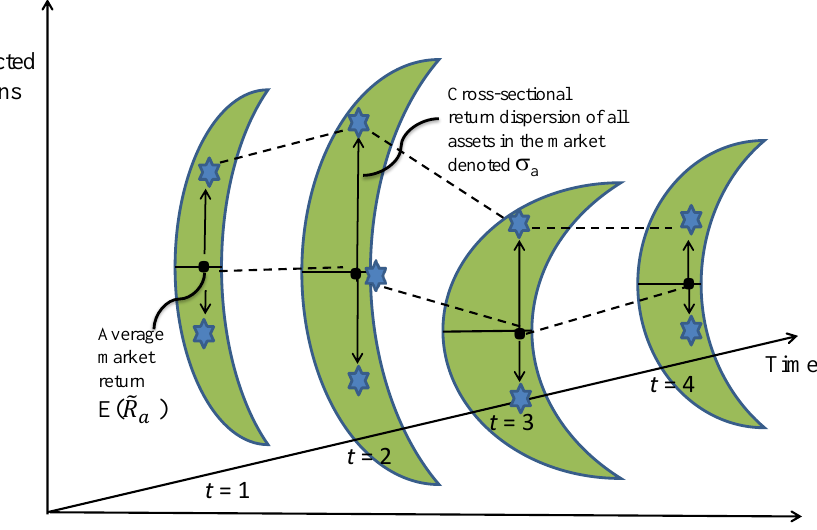
Figure 2. As the investment parabola moves over time t , its level and width change. The level changes with average market returns, and the width changes with cross-sectional return dispersion of all assets in the market. Assets in the upper (lower) half of the parabola experience opposite return effects of changing return dispersion, whereas as all assets’ returns move up and down in concert with the average market